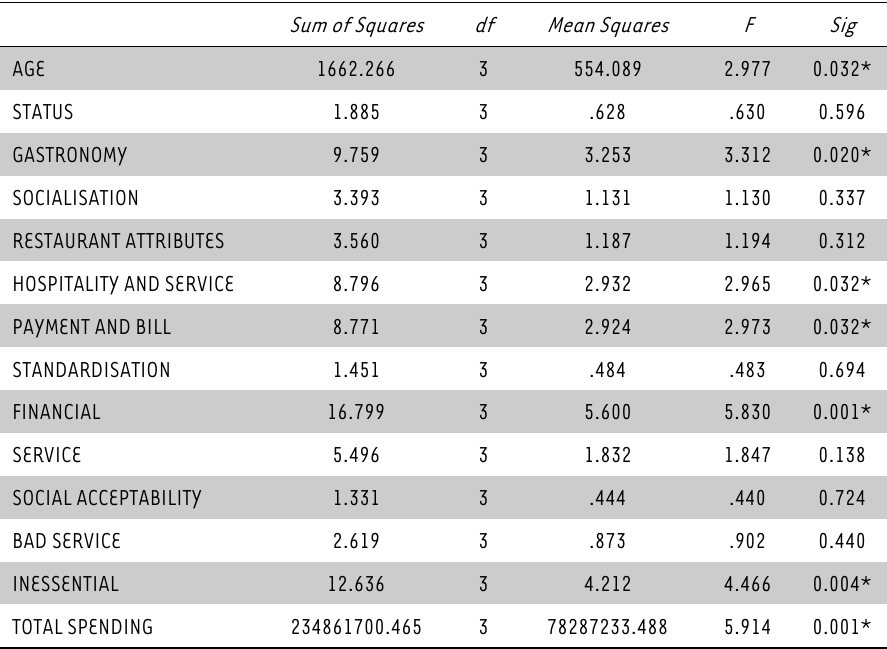
TABLE 2: Results of ANOVA Sum of Squares df Mean Squares F